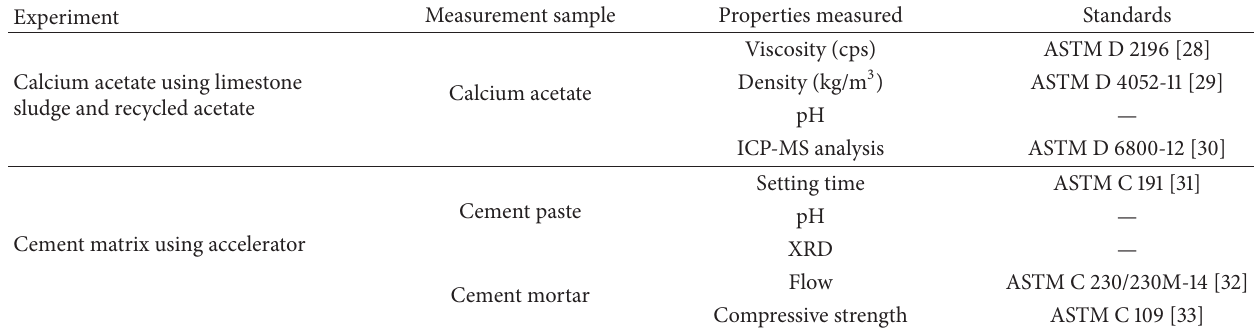
Table 5: Measurements and methods.